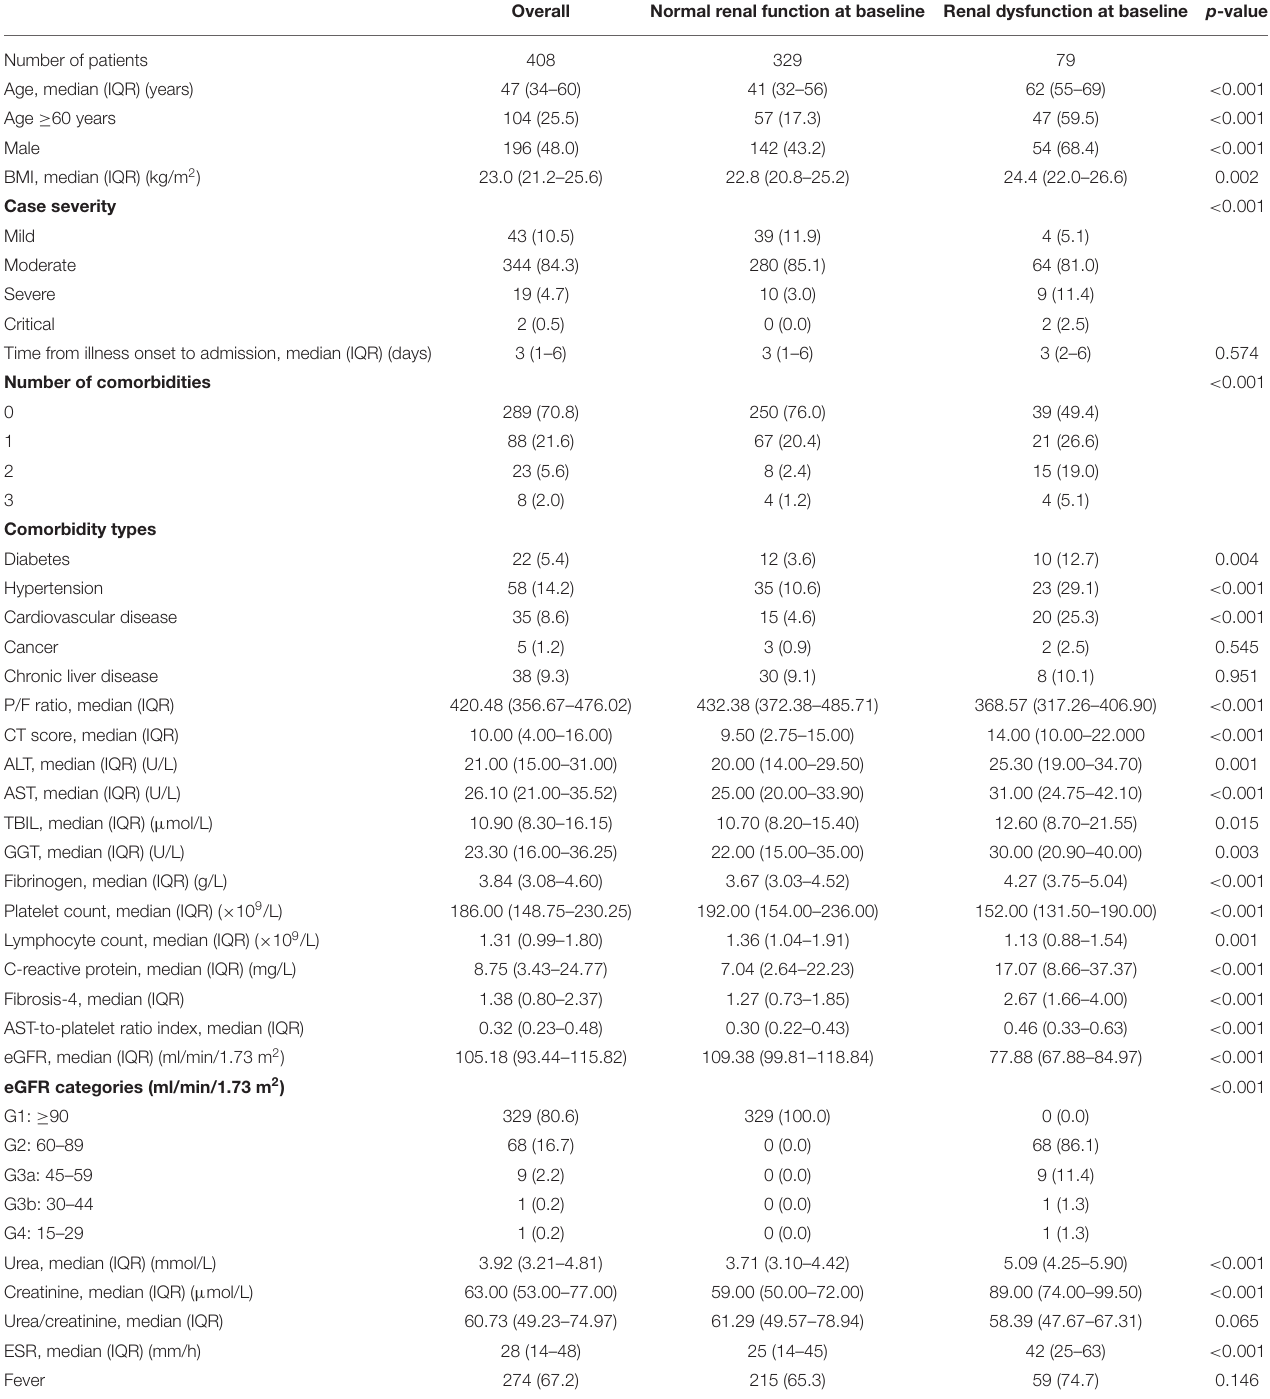
TABLE 1 | Baseline characteristics of the selected COVID-19 patients for this study. Overall Normal renal function at baseline Renal dysfunction at baseline p -value Number of patients